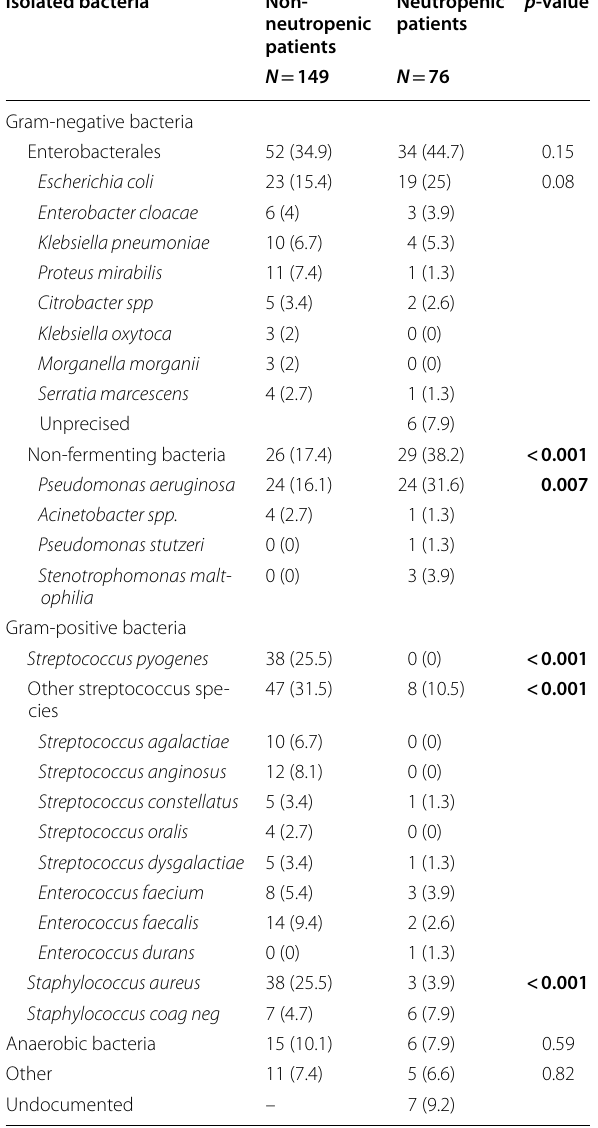
Table 2 Microbiological documentation in NSTIs according to Table 3 Univariable and multivariable Cox analyses of